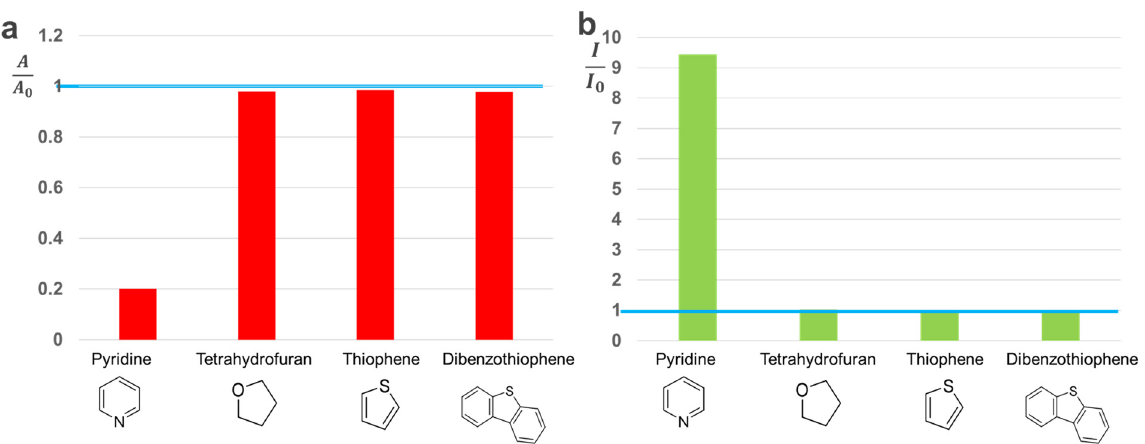
Figure 8. Selectivity of the NCOBs sensing assay towards oxygen and sulfur containing compounds: ( a ) UV-vis absorption-based assay, where A 0 is the UV-vis absorption intensity of C-dots at 626 nm without any analytes, and A is the UV-vis absorption intensity of C-dots at 626 nm in the presence of 10 − 3 M analytes. ( b ) PL-based assay, where I 0 is the PL intensity of C-dots at 606 nm without any analytes, and I is the PL intensity of C-dots at 606 nm in the presence of 10 − 3 M